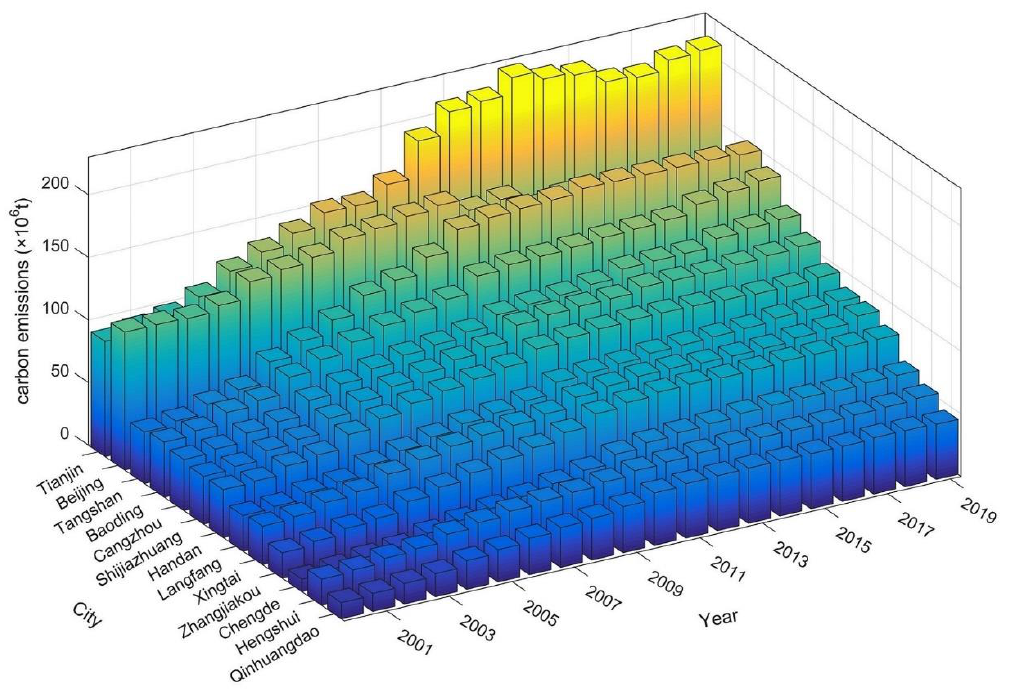
Figure 8. Beijing – Tianjin – Hebei municipal-level energy CO 2 emissions from 2000 – 2019.